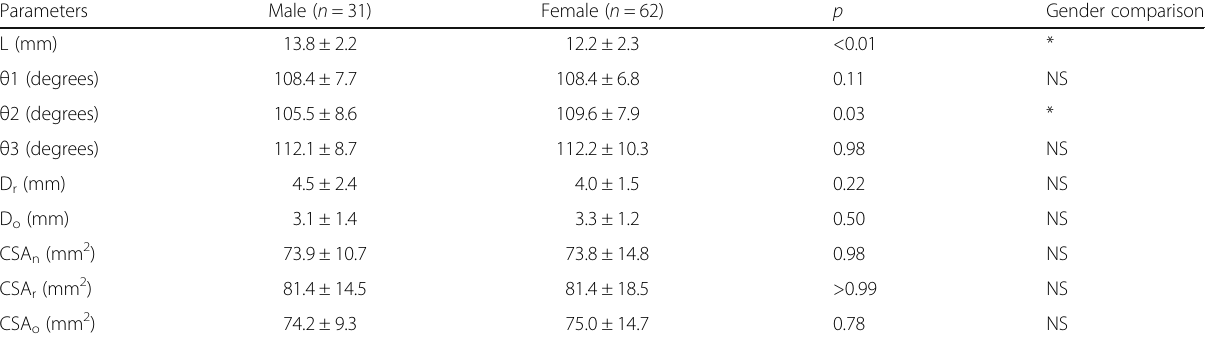
Table 1 Differences in linear, angular, and area measurements according to sex Parameters